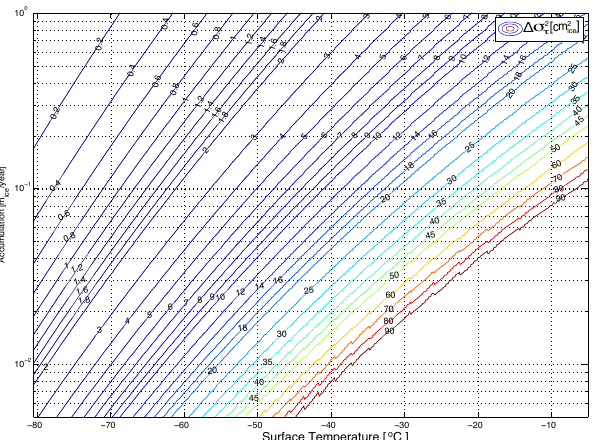
Fig. 3. Modelled diffusion lengths along the NorthGRIP ice core, based on NorthGRIP isotope borehole thermometry (shown in the lower panel). Also shown for reference is the δ 18 O record for NorthGRIP. As seen in the top panel, the modelled differential dif- fusion lengths are almost not seen in the interstadials in the Last Glacial. For the modelling of the diffusion length of δ 17 O the frac- tionation constants reported by Barkan and Luz (2007) are